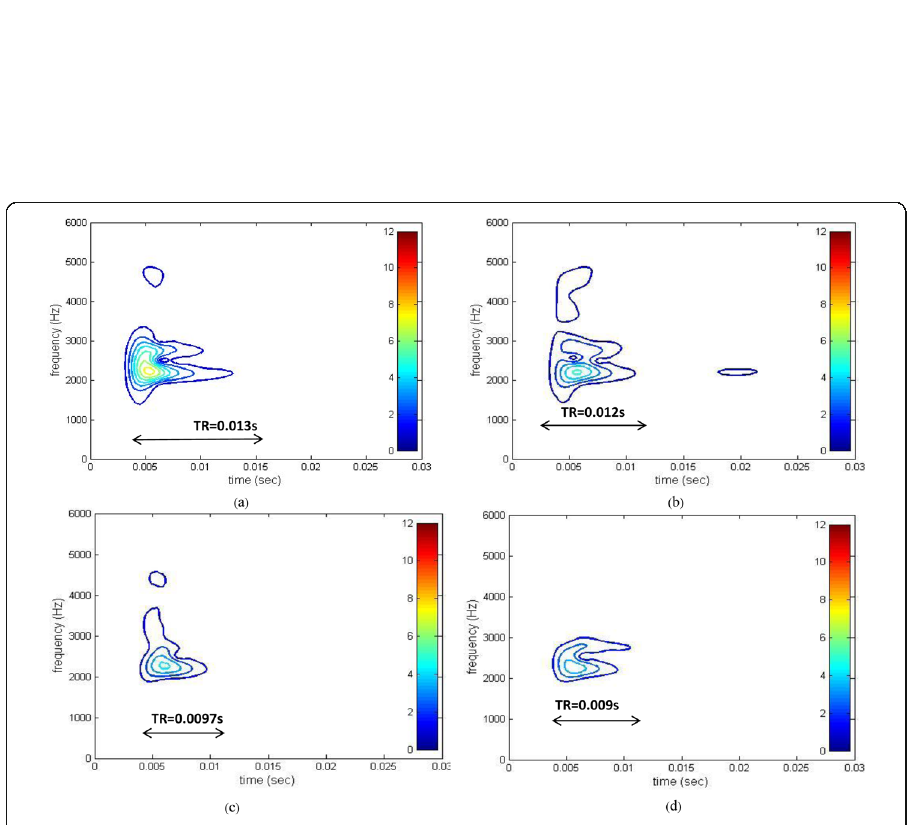
Fig. 18 Case 3: cavity size 5 × 5 × 1.25 cm. a Sensor at 5 cm. b Sensor at 10 cm. c Sensor at 15 cm. d Sensor at 20